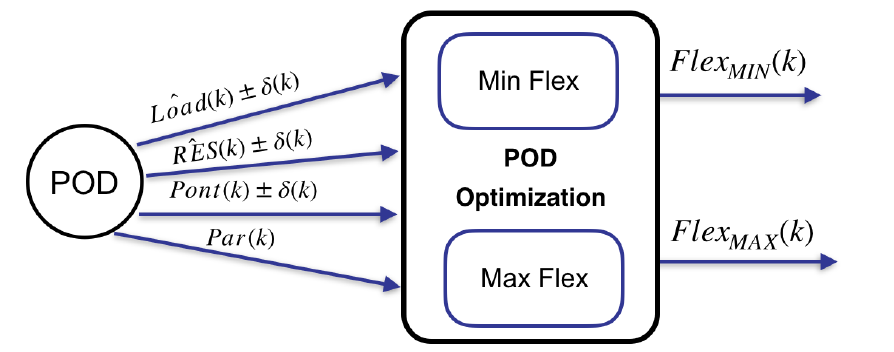
Figure 7. Examples of PODs.